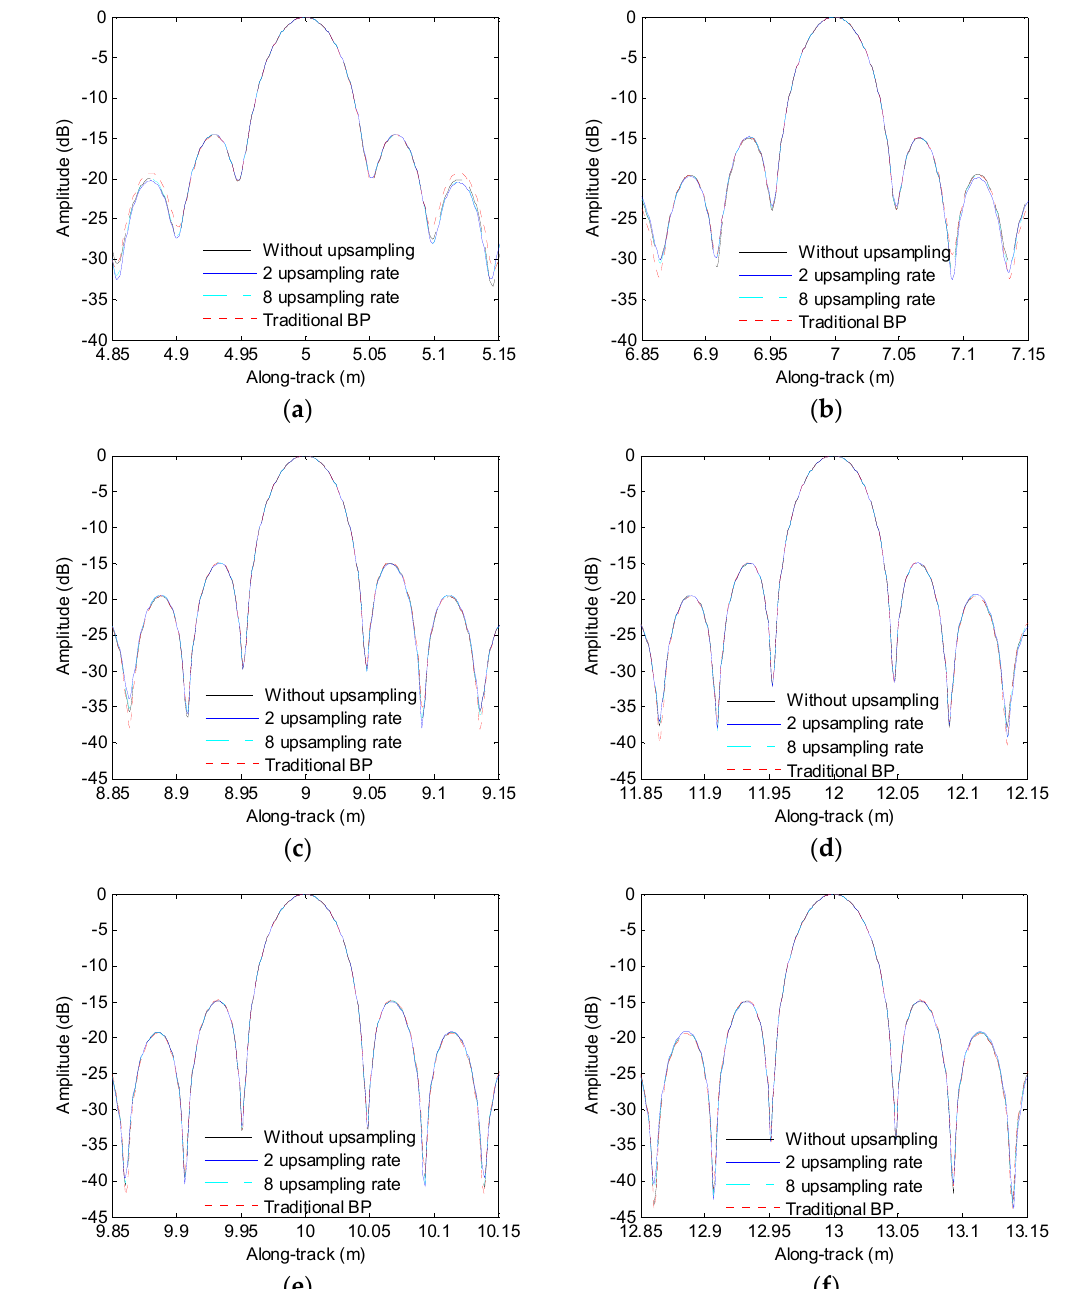
Figure 10. Close look at along − track slices. ( a ) T1; ( b ) T2; ( c ) T3; ( d ) T4; ( e ) T5; ( f ) T6. The quality parameters such as the PSLR and integrated sidelobe ratio (ISLR) are calculated in Table 3. The PSLR [31] is defined by the ratio of the largest level of sidelobes to the peak level of the mainlobe. Here, the mainlobe is defined as the − 3 dB width of the along-track slice. PSLR represents the sonar’s ability to identify a weak target from a nearby strong one. The ISLR [31] is the ratio of the total power in all of the sidelobes to the power in the mainlobe. It characterizes the ability to detect weak targets in the neighborhood of bright targets. From Table 3, the PLSR based on the nearest interpolation without upsampling and traditional BP is mostly identical. This conclusion is consistent with that drawn from Figure 6. However, the major difference of ISLR between both methods is 0.59 dB. With the presented method, the imaging performance can be improved. When